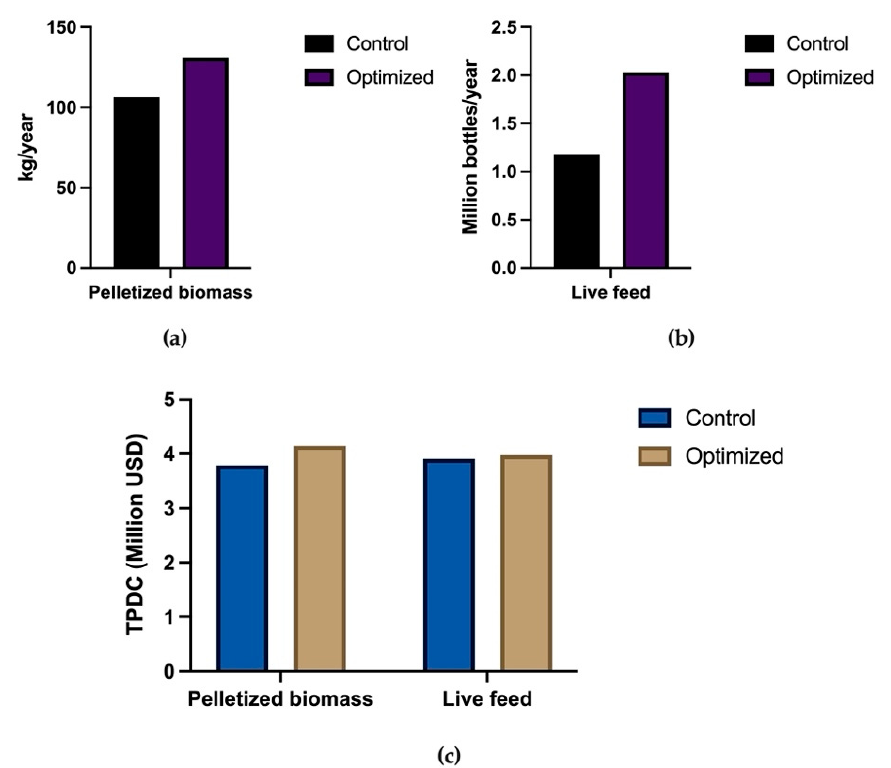
Figure 6. Biomass production for year-pelletized biomass ( a ) and live feed ( b ); total plant direct cost for two scenarios of biomass production ( c ).